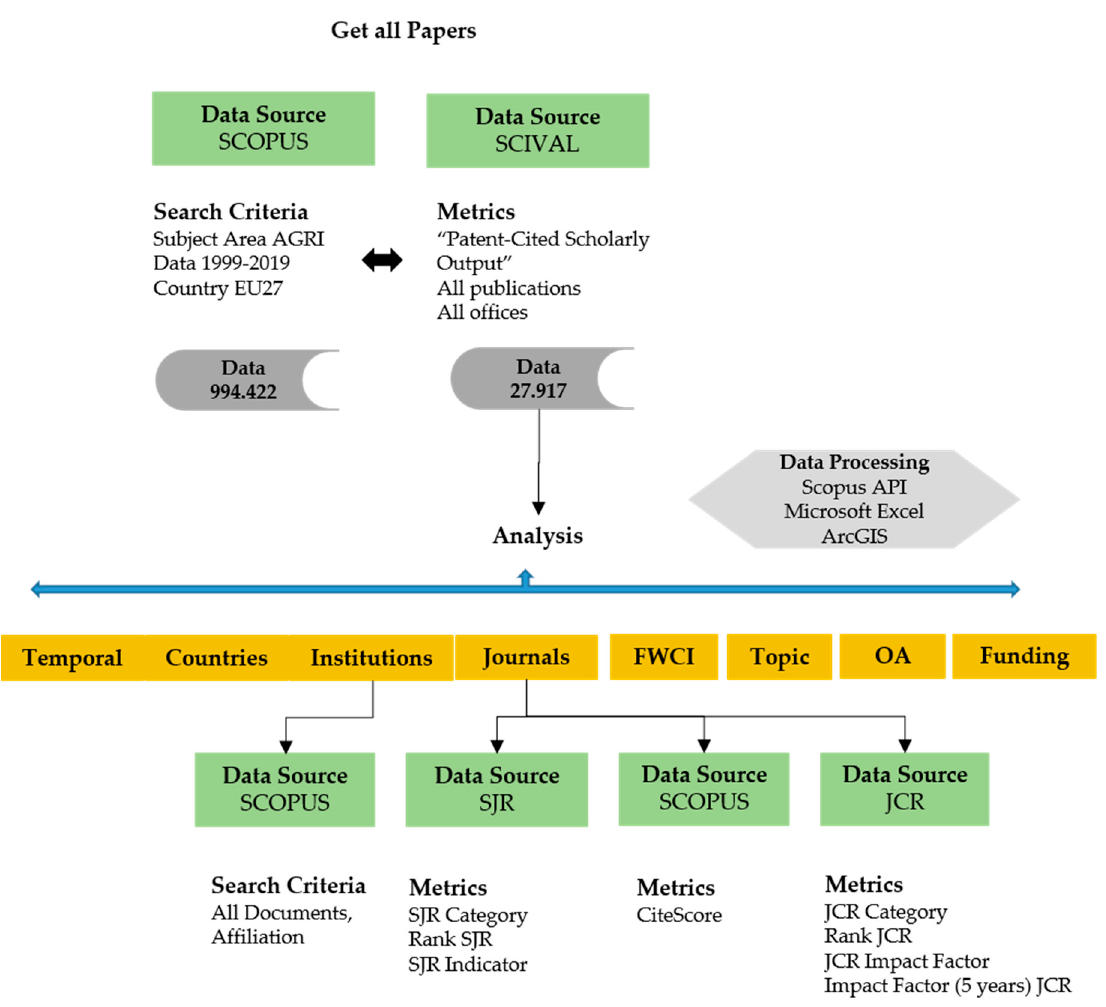
Figure 1. Methodology flowchart.